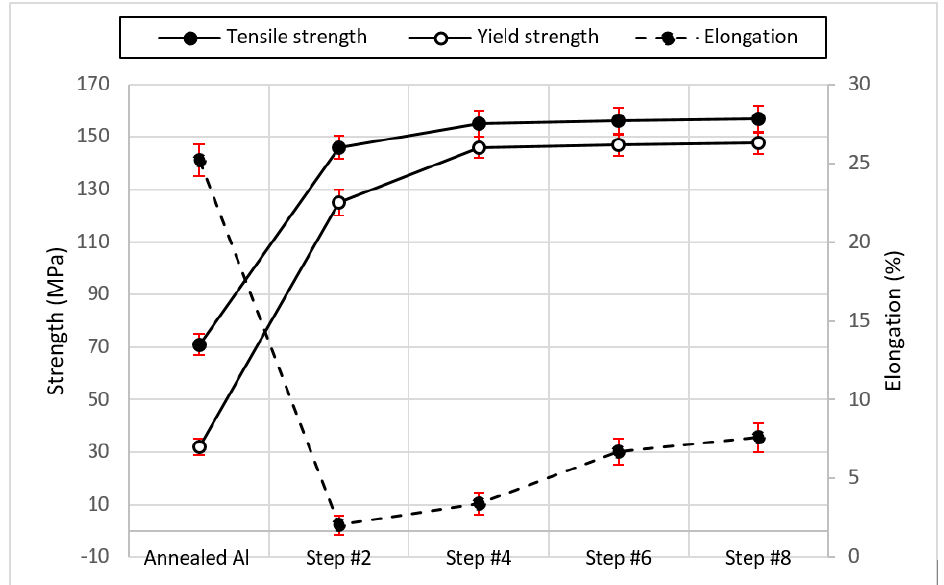
Figure 4. Mechanical properties of Al/TiC composites.